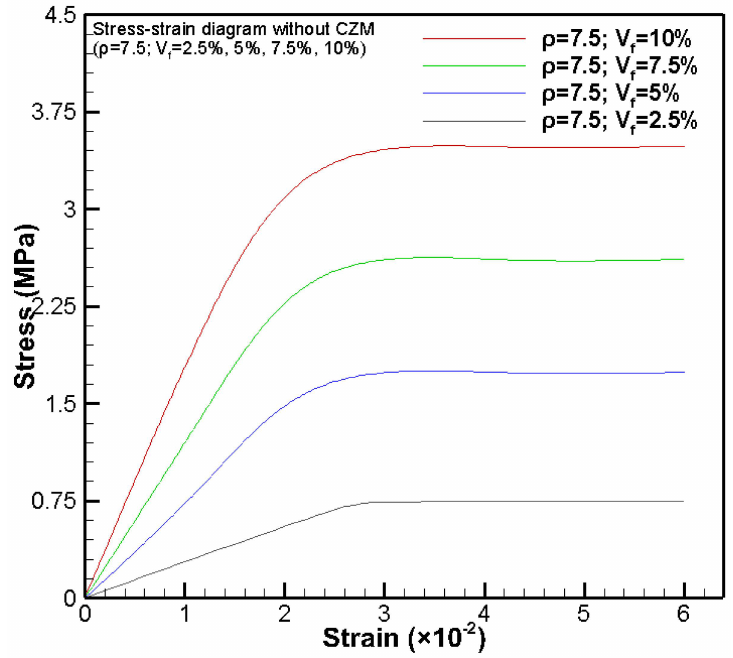
Figure 16. Effective stress-strain diagrams of the PNC (stack nanoparticle configuration) without CZM at the nanoparticle volume fraction of V f = 2.5%, 5%, 7.5%, and 10%, respectively ( ρ = 7.5).